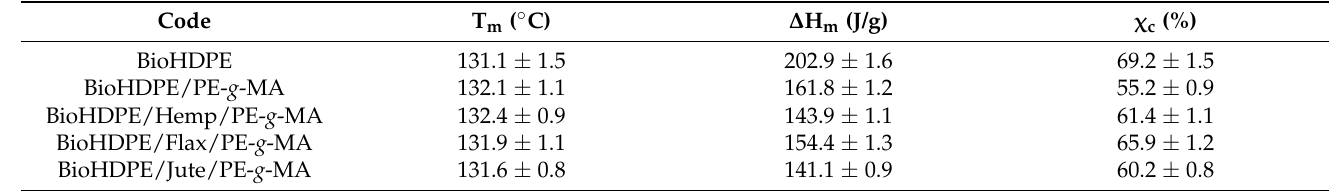
Table 3. Main thermal parameters of the injection-molded parts of Bio-HDPE with different natural fibers in terms of: melting temperature (T m ), normalized melting enthalpy ( ∆ H m ), and degree of crystallinity ( χ c ).